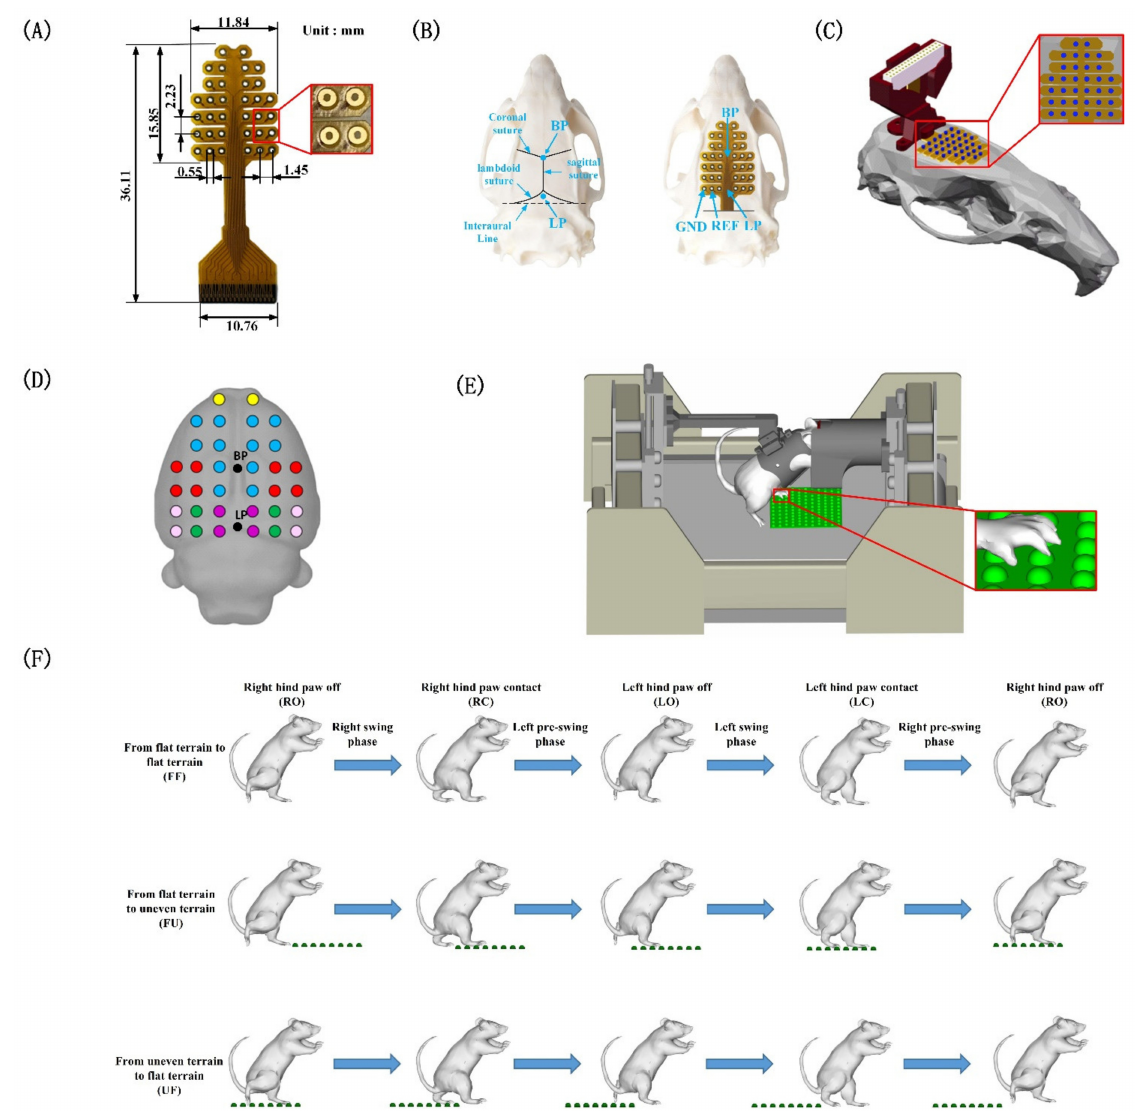
Figure 1. Experimental setup. ( A ) The 32-channel flexible electrode arrays used in this study. ( B ) The installation position of the electrode on the rat skull and electrode locations were based on stereotaxic coordinates from the bregma point (BP) and lambda point (LP). The BP is defined as the intersection of the coronal and sagittal sutures. LP (midpoint of the curve of best fit along the lambdoid suture) is 0.3 mm anterior to the coronal plane passing through the interaural line. ( C ) The electrodes were fixed on the skull with screws and a protective shell was installed. The blue dots represent screws that attach the electrodes array to the skull. ( D ) The putative electrode positions on the rat’s brain surface, as determined by Brainstorm3. The colors of the electrodes correspond to the different brain regions (yellow: frontal area; blue: somatomotor area; red: somatosensory area; purple: retrosplenial area; green: visual area; pink: posterior parietal association area). ( E ) The rat walked in a bipedal posture on the treadmill with the help of a suspension device, and a black tube was used to block all frontal visual cues on the upcoming terrain. A removable uneven area was set on the surface of the treadmill belt. ( F ) Behavioral tasks, gait events, and gait cycle phases were